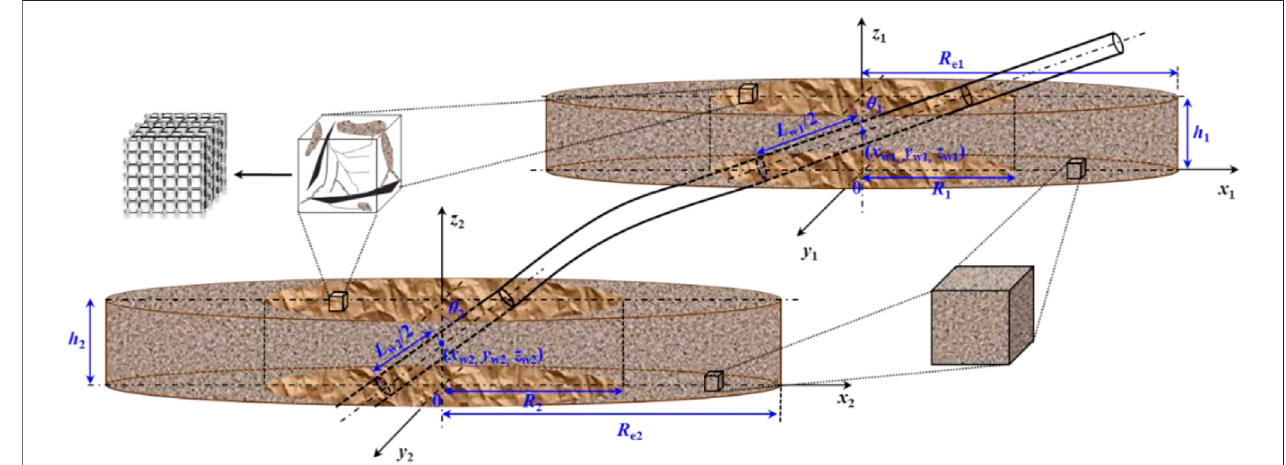
FIGURE 1 | Schematic of inclined well in multilayer heterogeneous commingled carbonate